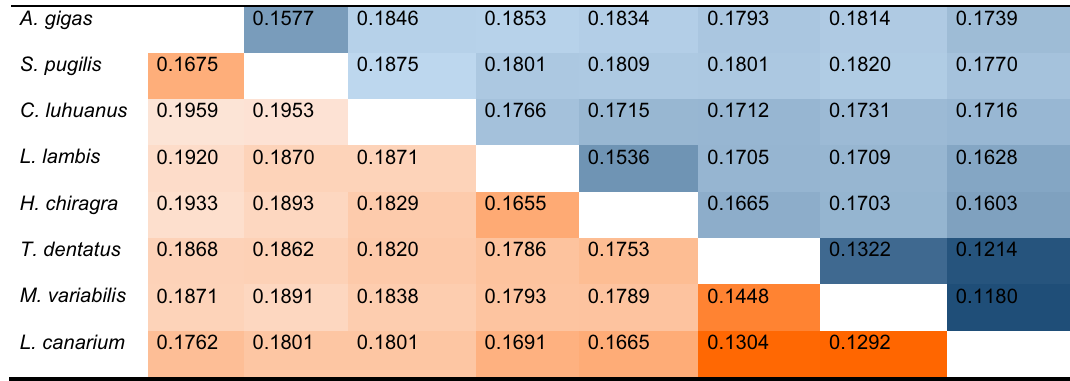
( C. luhuanus ), Lambis lambis ( L. lambis ), Harpago chiragra ( H. chiragra ), Tridentarius dentatus ( T. dentatus ), Ministrombus variabilis ( M. variabilis ), and Laevistrombus canarium ( L. canarium